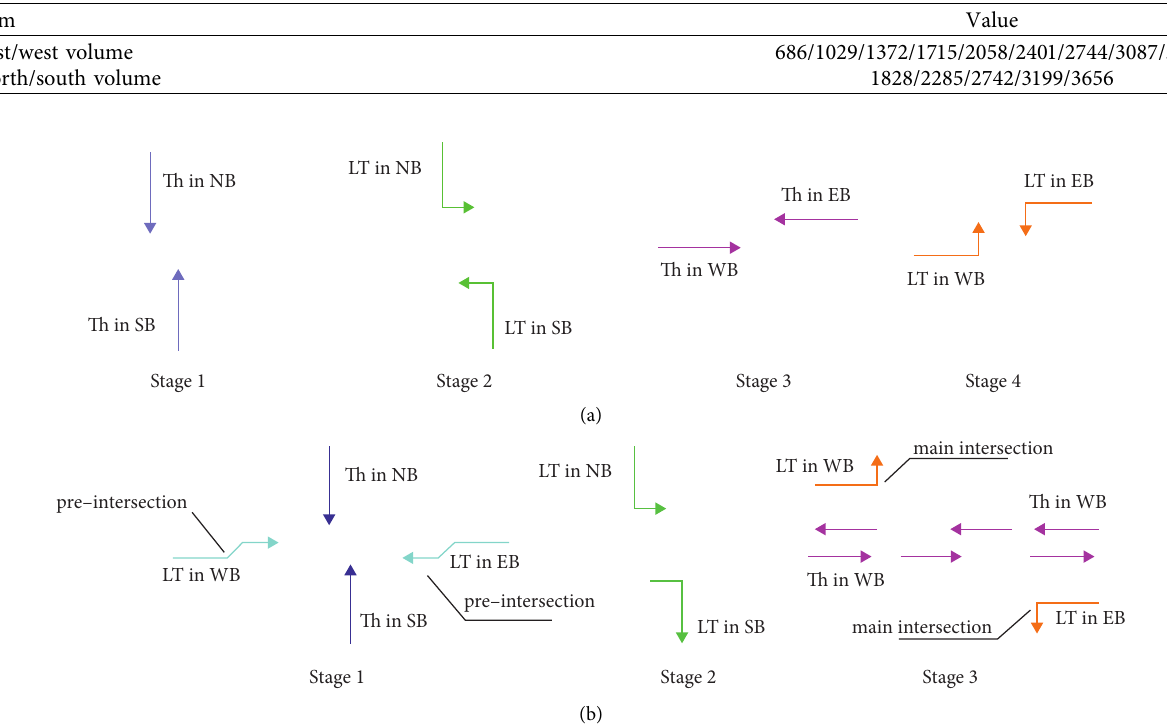
Figure 8: Signal timing stage diagram for existing intersection and improvement schemes with added DLT lanes. (a) Existing intersection. (b) Improvement intersections with added DLT lanes. EB, WB, NB, and SB denote Eastbound, Westbound, Northbound, and Southbound, respectively. LT and Th denote Left-Turn and Through, respectively.